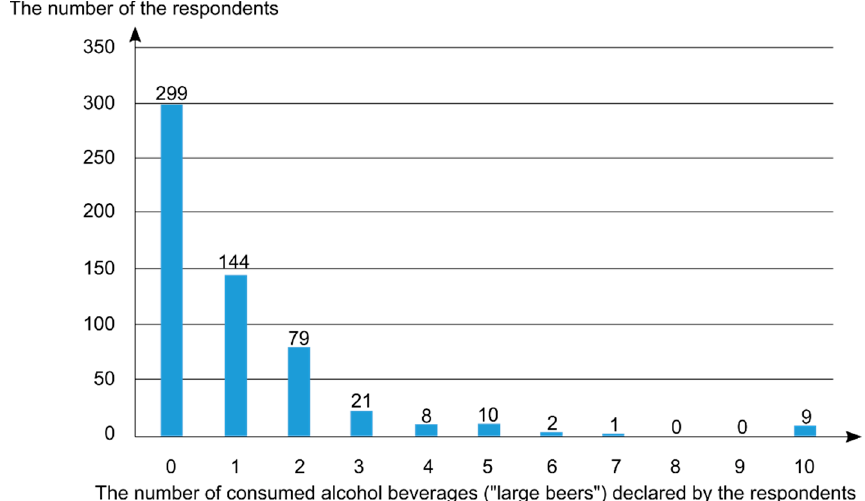
Figure 12. Number of consumed alcoholic beverages (“large beers”) declared by construction workers during a day (own elaboration). Table 4. The number of people consuming alcohol (“Yes”), and the number of abstainers (“No”), with regards to their age (own elaboration).